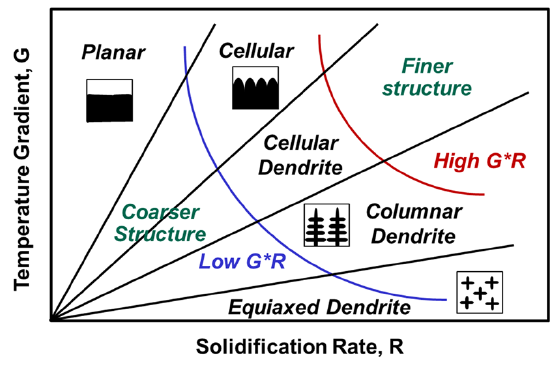
Figure 3. Effect of R and G in the solidification process [45].